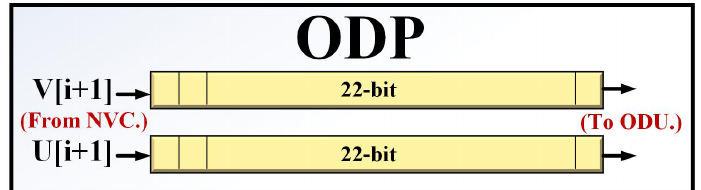
Figure 10. Output signals that are stored in an ODP unit.